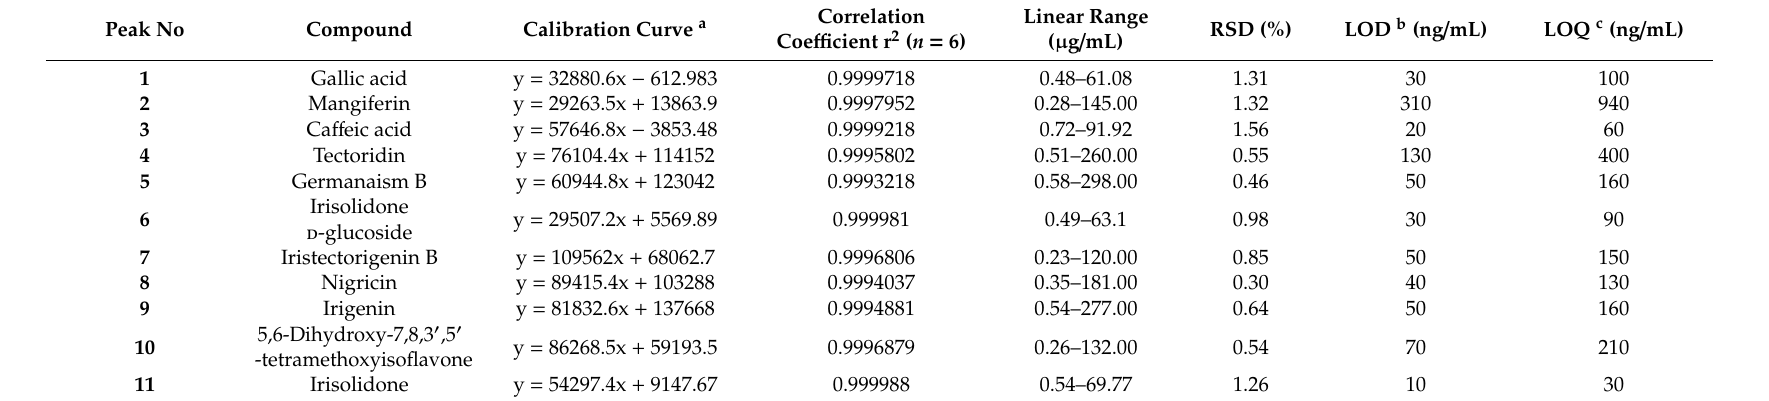
Table 1. Calibration curves, LOD, and LOQ data of eleven phenolic reference compounds.